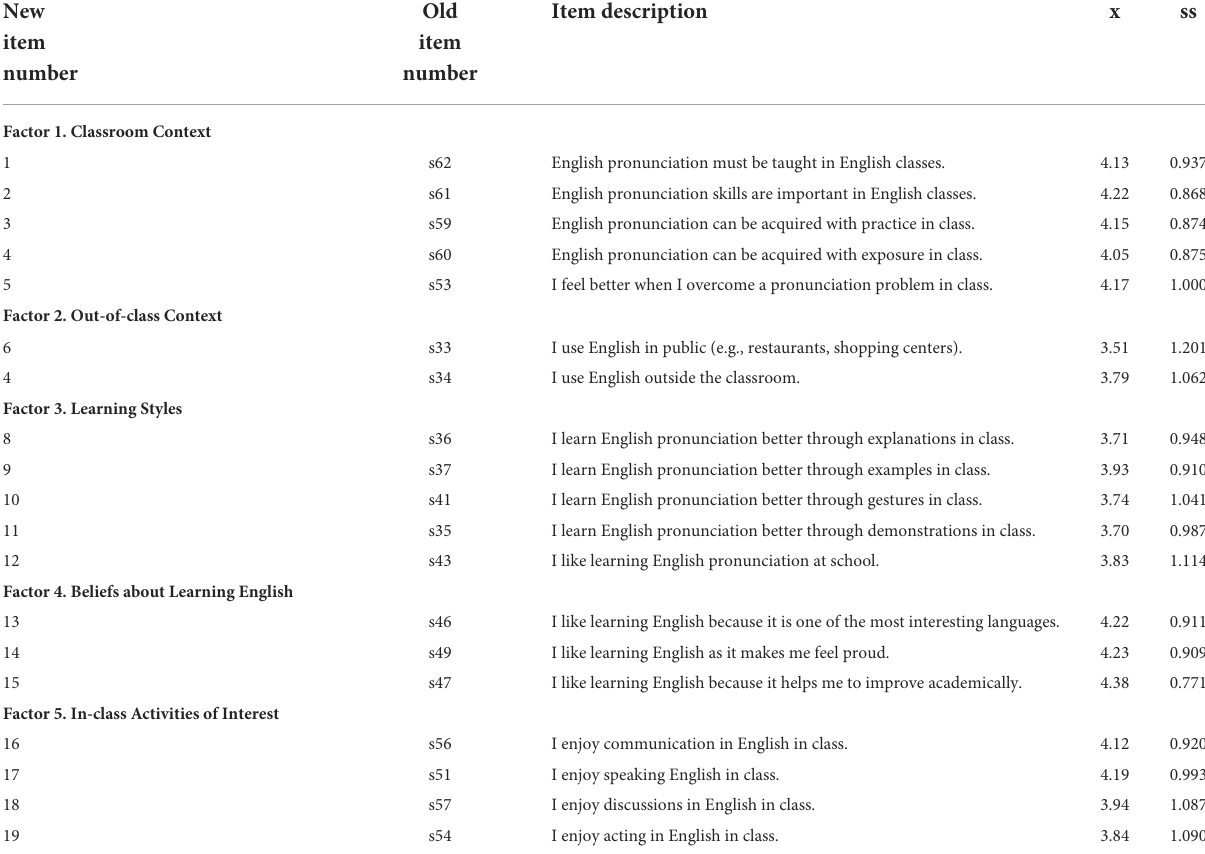
TABLE 5 Pronunciation teaching perception scale (PTPS) for preservice English language